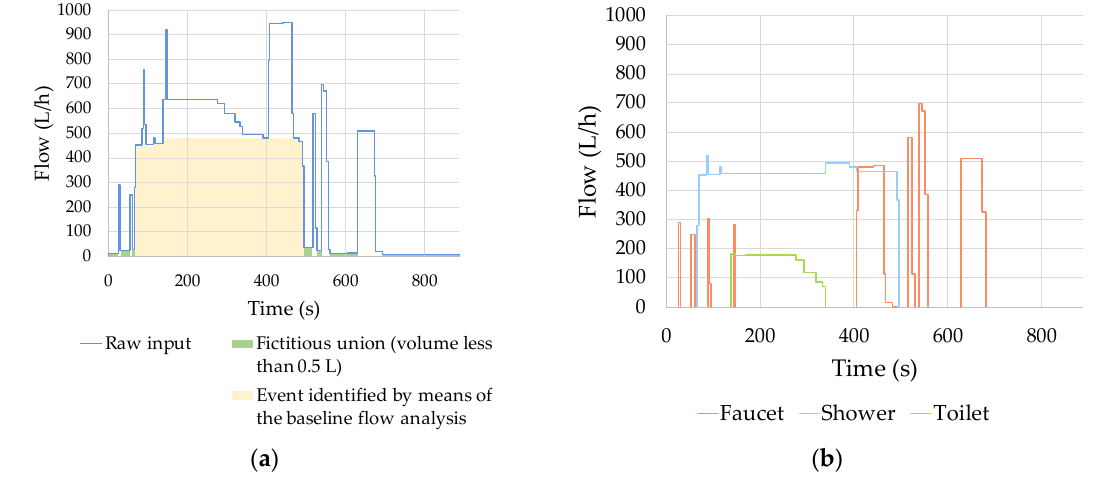
Figure 4 . ( a ) Example of an overlapped event. ( b ) Resulting events obtained after disaggregating fictitious unions and conducting a baseline flow analysis.